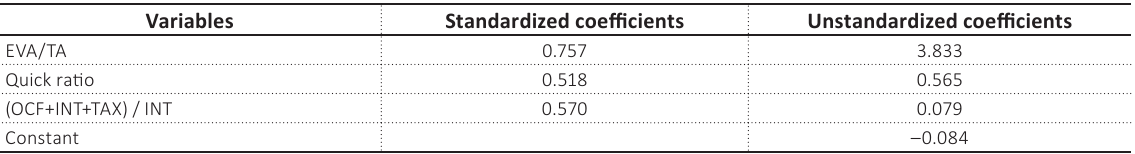
Table 9. Coefficients of the discriminant function ( t –2)